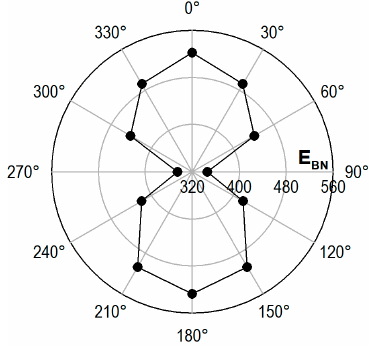
Figure 6. Polar diagram illustrating average Barkhausen noise energy E BN in the place of the specimen narrowing (0–180°—direction parallel to the tensile load direction, 90–270°—direction normal to the tensile load direction).